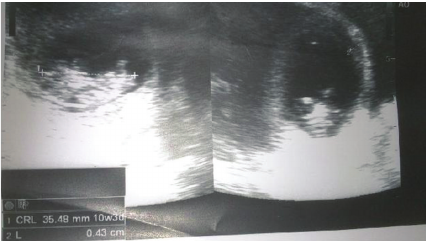
Figure 1: Transabdominal ultrasound showing gestational sac with fetus in the lower uterine segment.